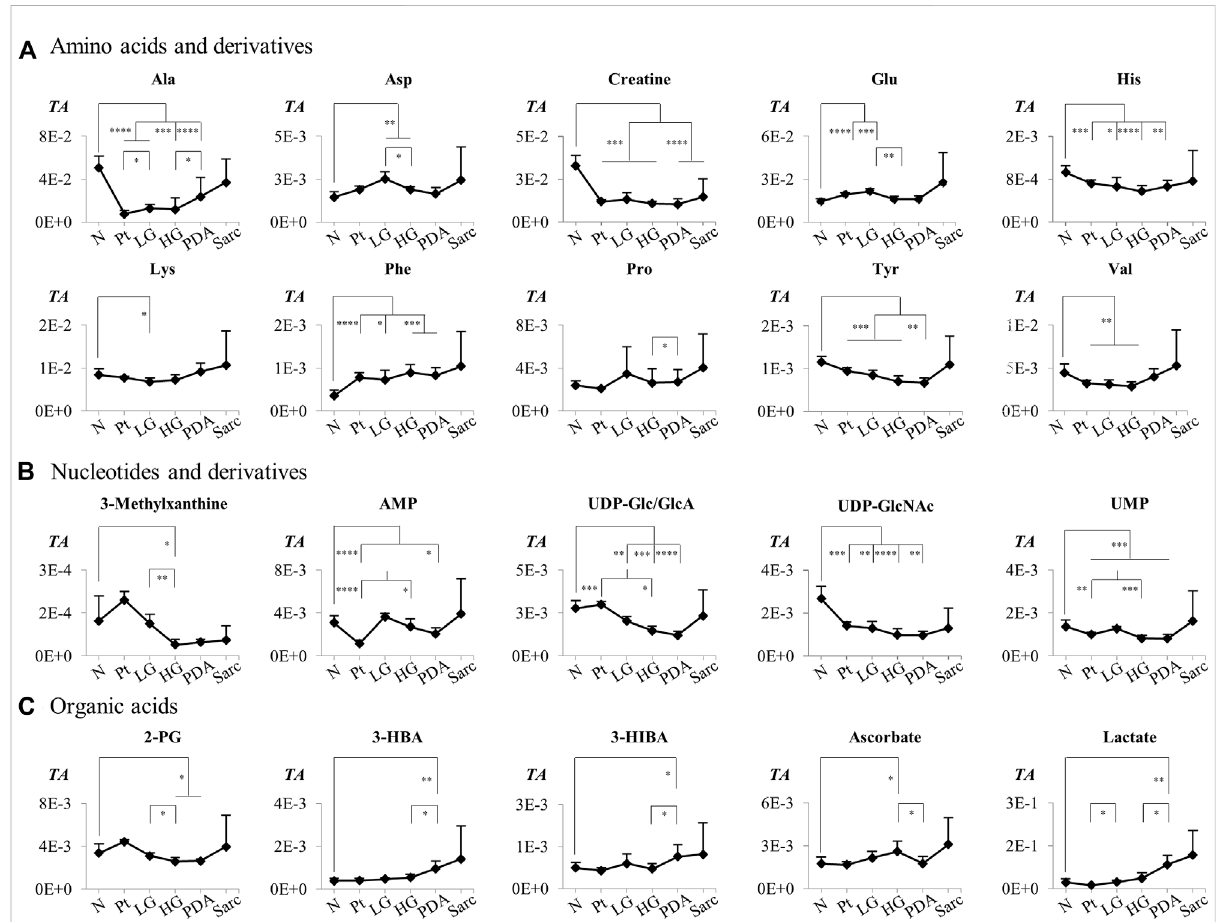
FIGURE 5 Variations in (A) amino acids and derivatives, (B) nucleotides and related compounds, and (C) organic acids across pancreatic cancer progression, represented as normalized peak integrals in relation to total spectra area (TA). Abbreviations: 2-PG, 2-phosphoglycerate;